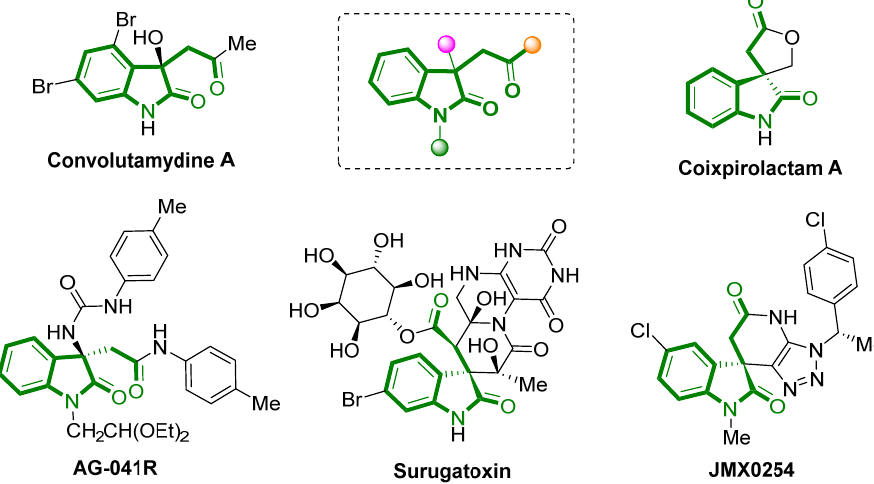
Figure 1. Carbonyl-containing oxindoles in natural products and pharmaceuticals.